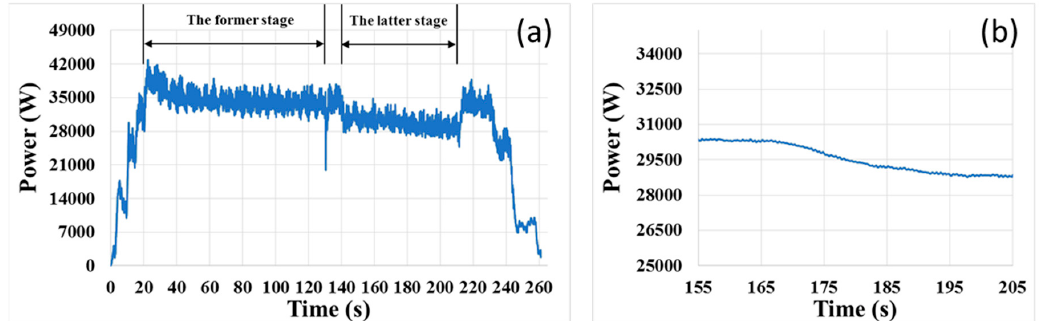
Figure 10. ( a ) Original motor power signal of polishing platen; ( b ) Smoothed signal curve of (a) during the transition region.